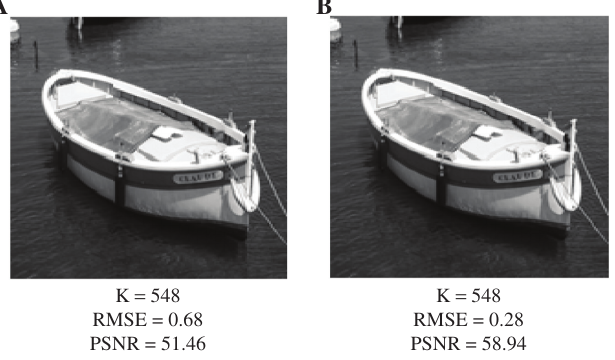
Figure 11: Compressed